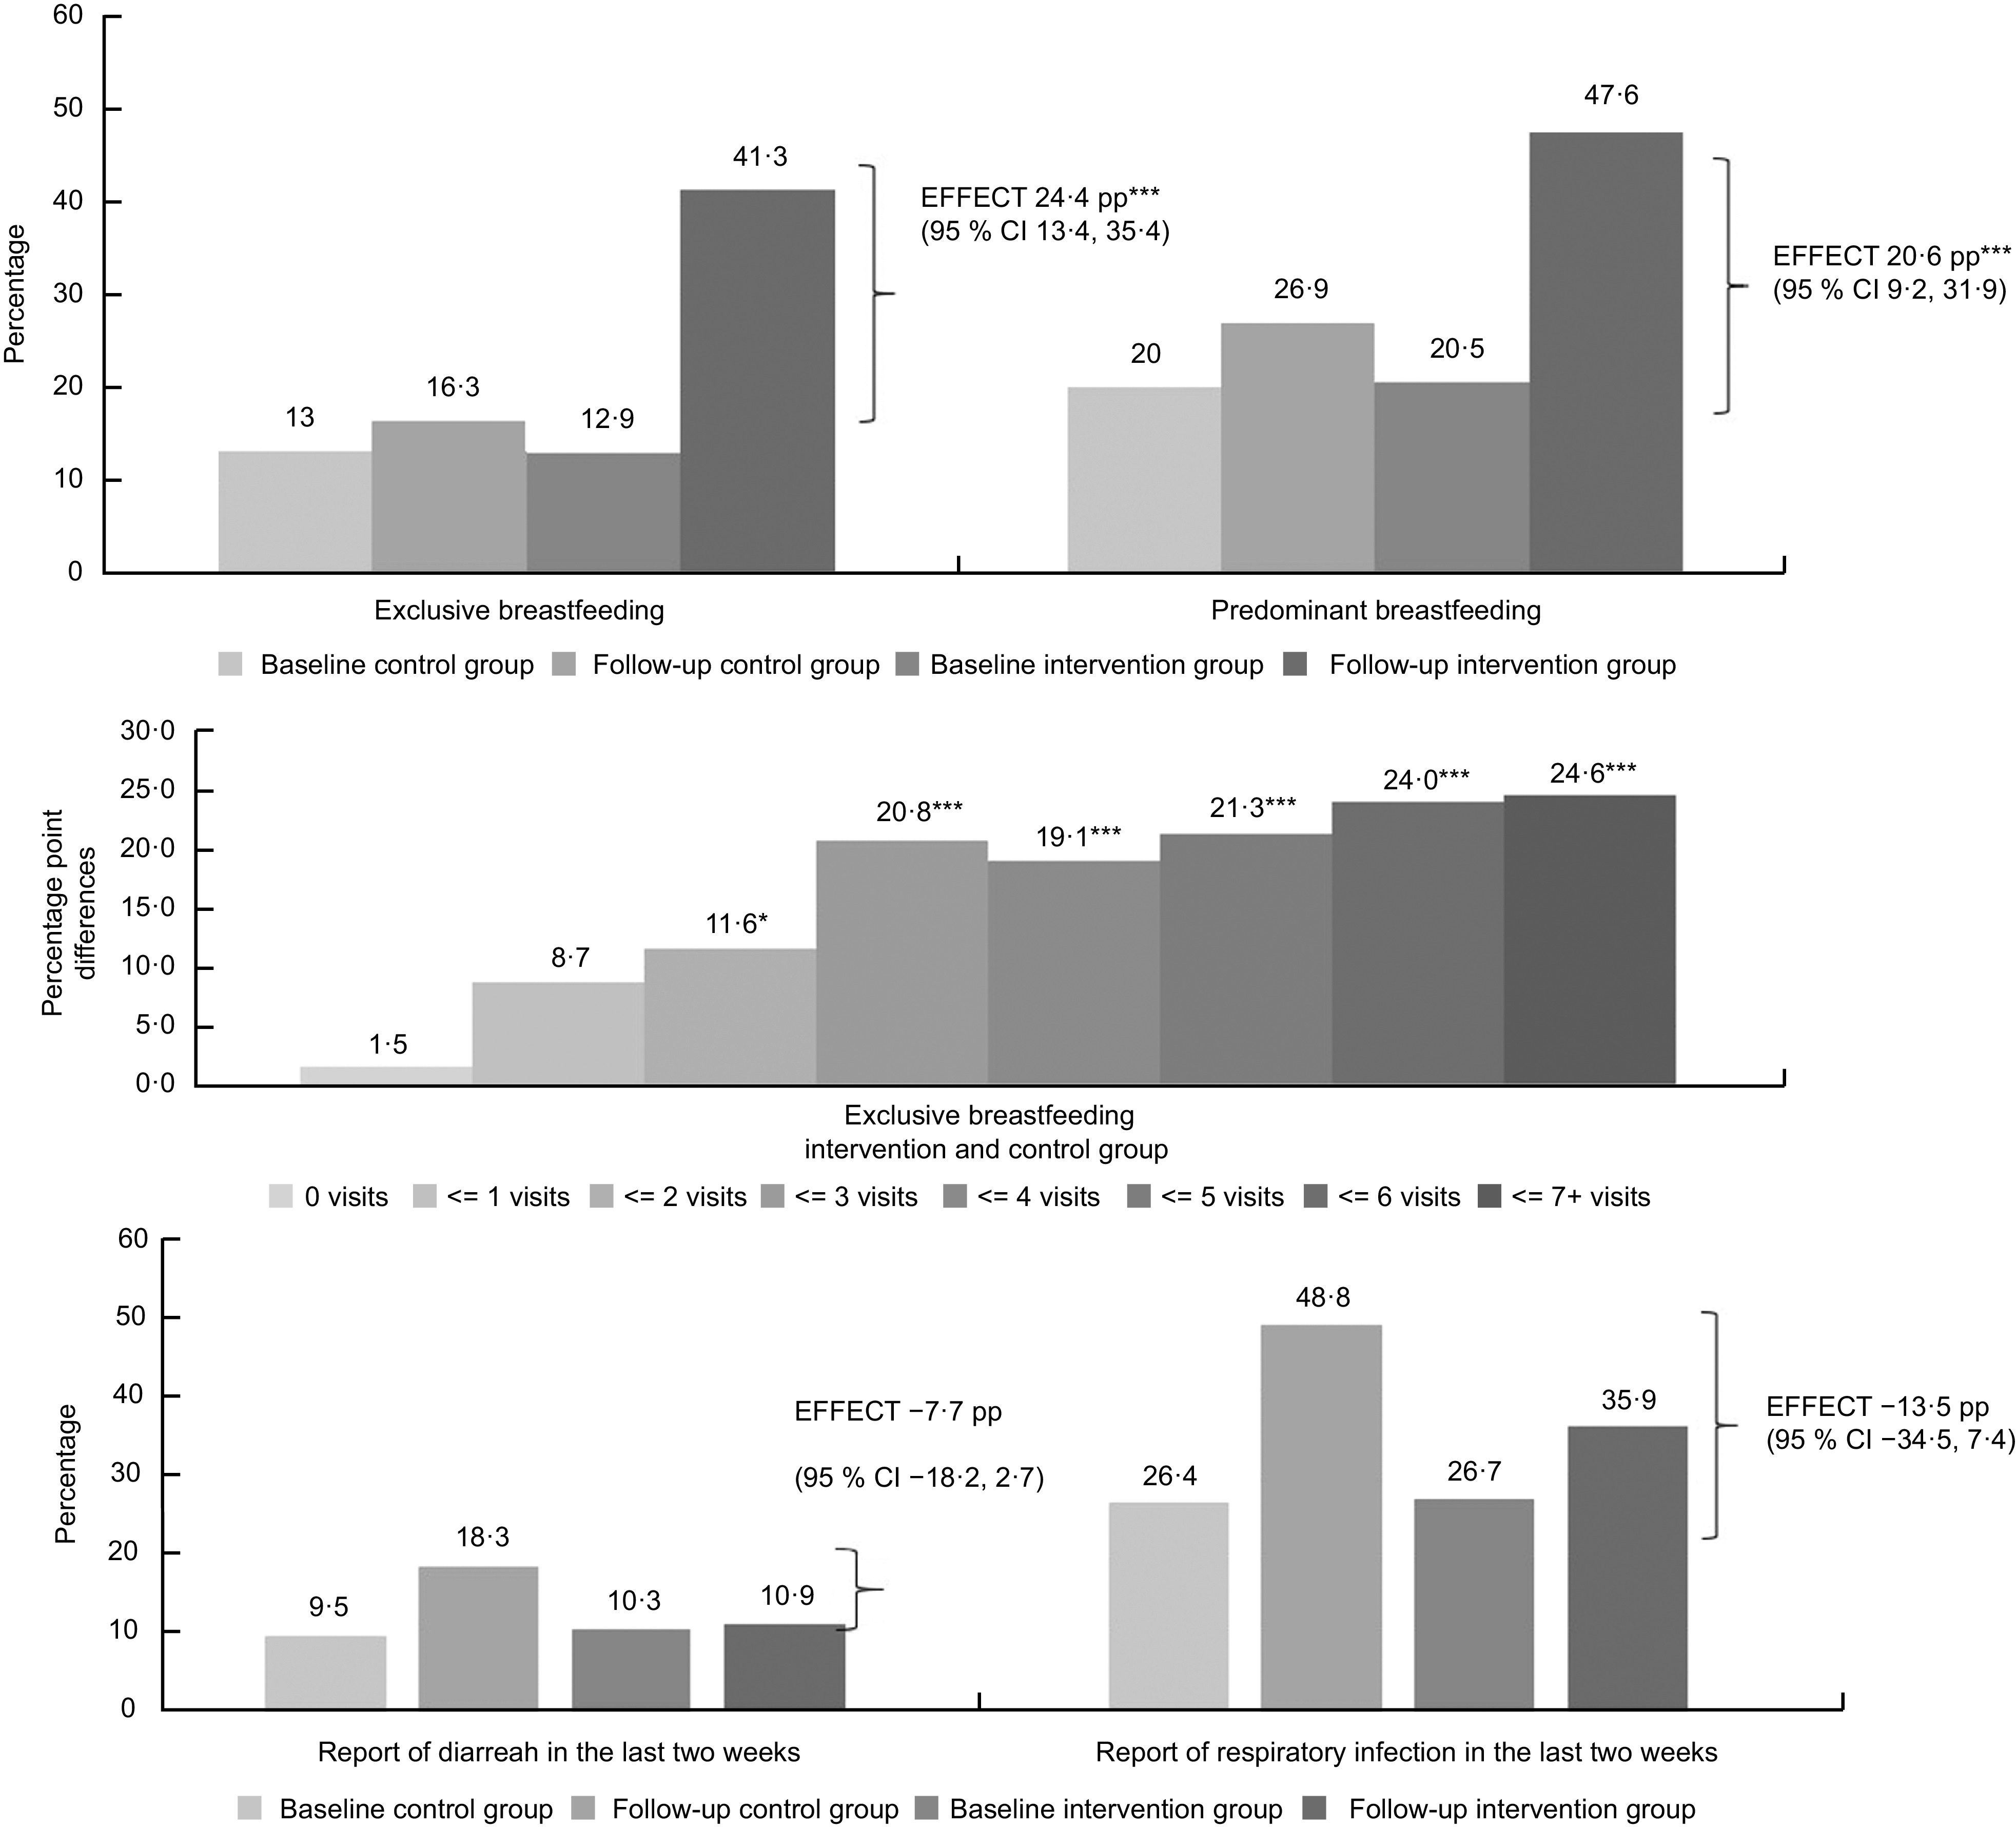
Report of breast-feeding practices and diarrhoea and respiratory diseases among children in intervention and control groups in the study ‘Caring for the Newborn and the Mother at Home’. Difference-in-difference model with fixed effects at the community level weighted by the inverse of the propensity score. Estimates adjusted by sociodemographic variables for the child and the mother. pp: Percentage points estimated through average marginal effects. Respiratory infections include flu, cold, angina, cough, bronchitis or ear infection. Differences are statistically significant at ***P < 0·01, **P < 0·05, *P < 0·10